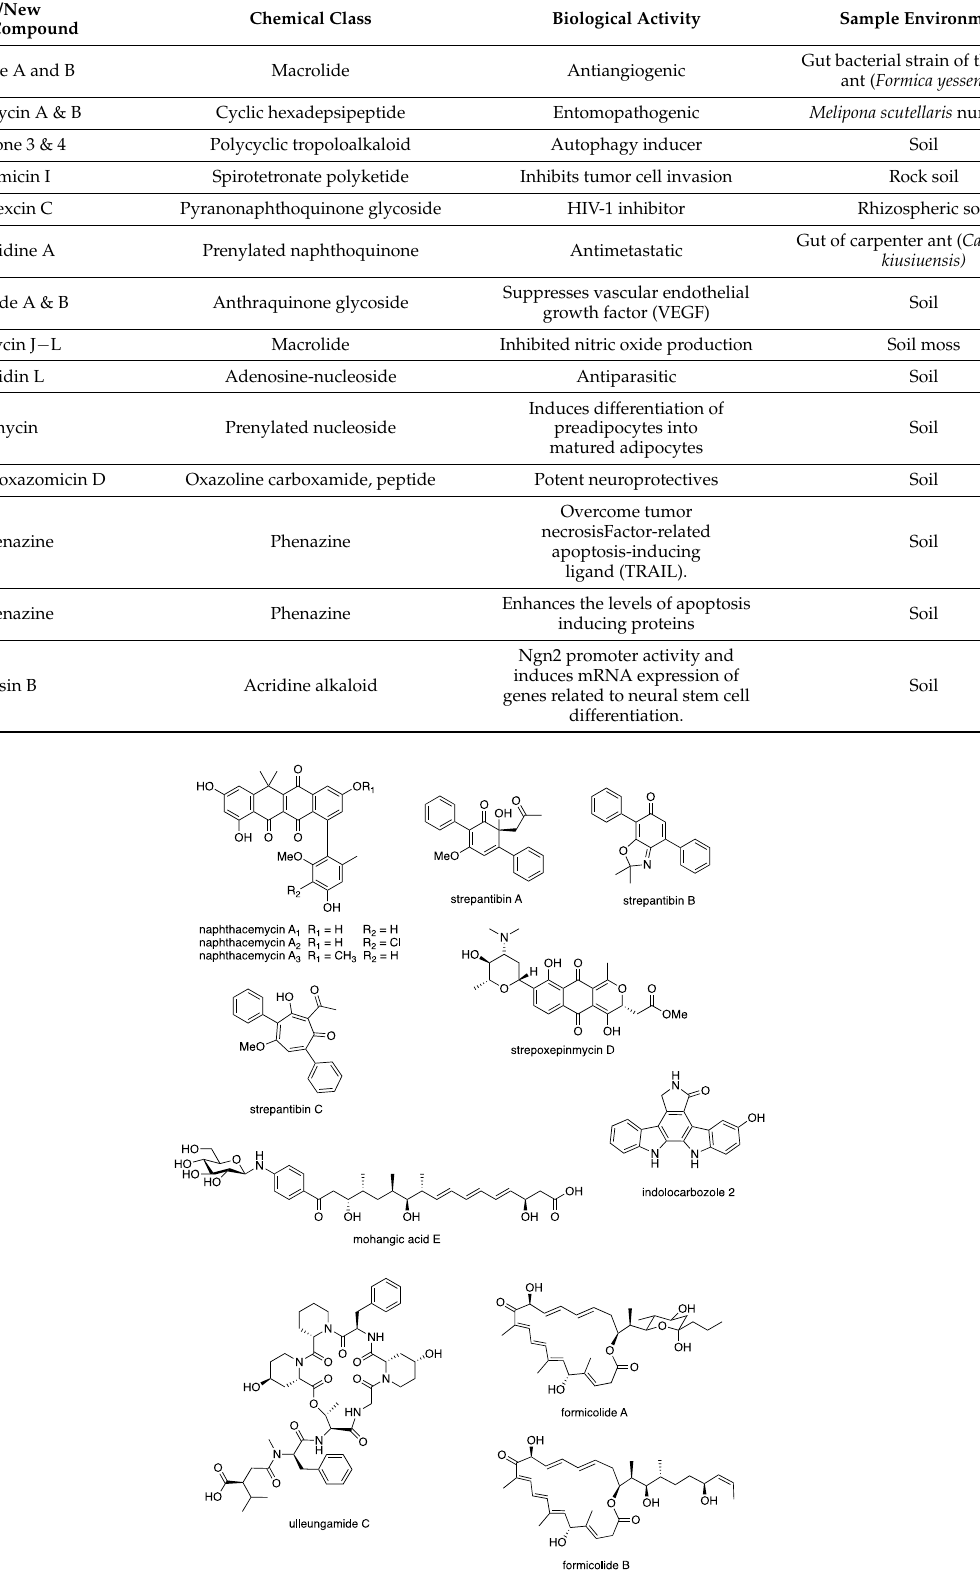
Figure 7. Examples of new compounds isolated from Streptomyces spp. between 2015 and 2020 with enzyme modulatory activity. 6.7. Antifungal New antifungal drugs are urgently needed to alleviate infectious diseases caused by pathogenic fungi. At present, drug resistant fungi are evolving continuously, so the need to find new antifungal drugs is increasing. For example, the multi-drug resistant fungi Candida albicans, Aspergillus fumigatus , and Candida glabrata have all been shown to be re- sistant to azole drugs after their drug binding sites mutated, thereby reducing binding affinity. In addition, other therapeutic antifungal drugs were also ineffective against these